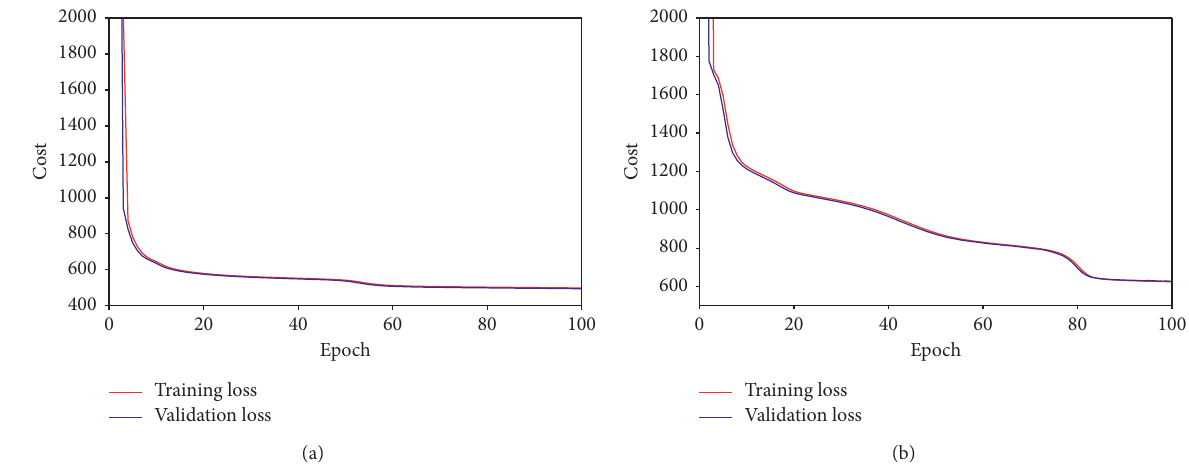
Figure 4: Training and validation cost value per number of epochs during the training process for the FD001 (a) and FD004 (b)